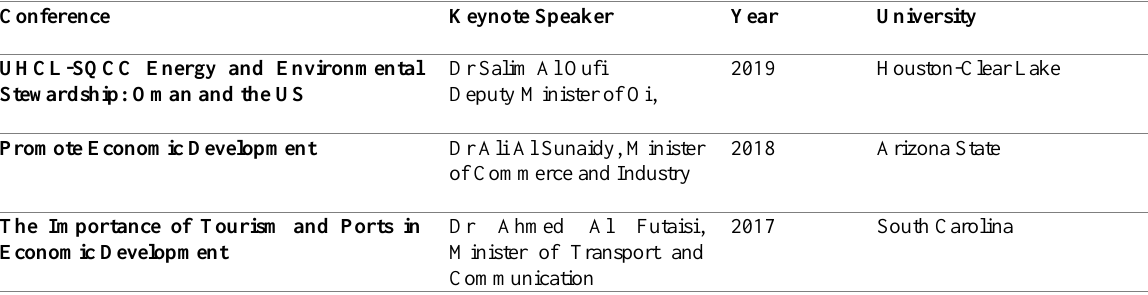
Table 3 : SQCC Annual Conferences and the Oman’s Policymakers